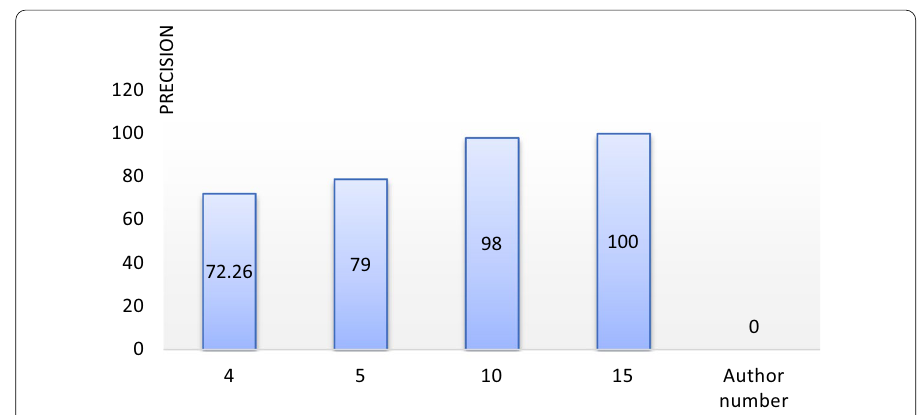
Fig. 6 Investigating the number of authors and